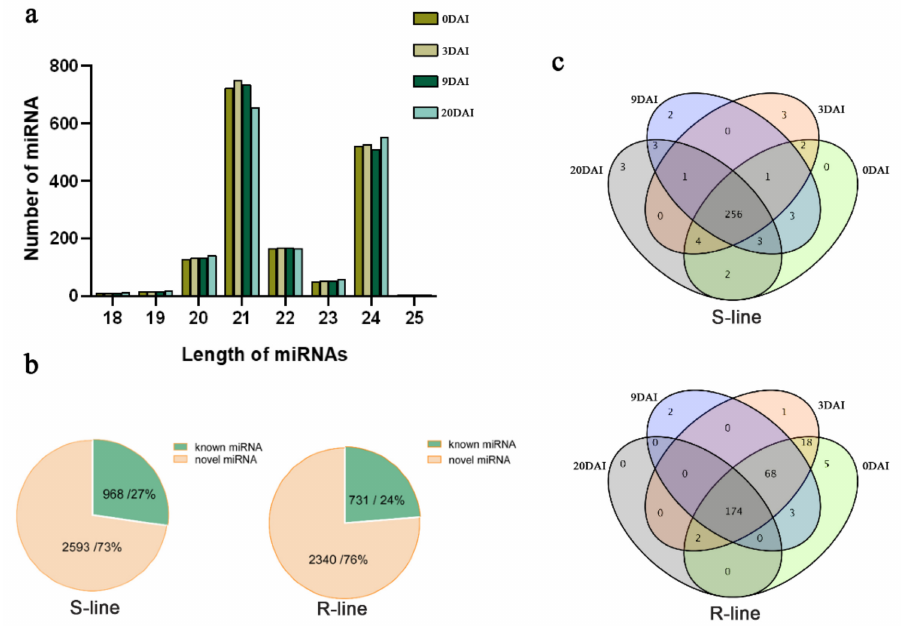
Figure 2. ( a ) Number of miRNAs distributed by different lengths found in different development periods of the two materials at 0, 3, 9, and 20 DAI. ( b ) The distribution of known and novel miRNAs in the R-line and in S-line. ( c ) Venn diagrams of differentially expressed miRNAs in different development periods in the two materials at 0, 3, 9, and 20